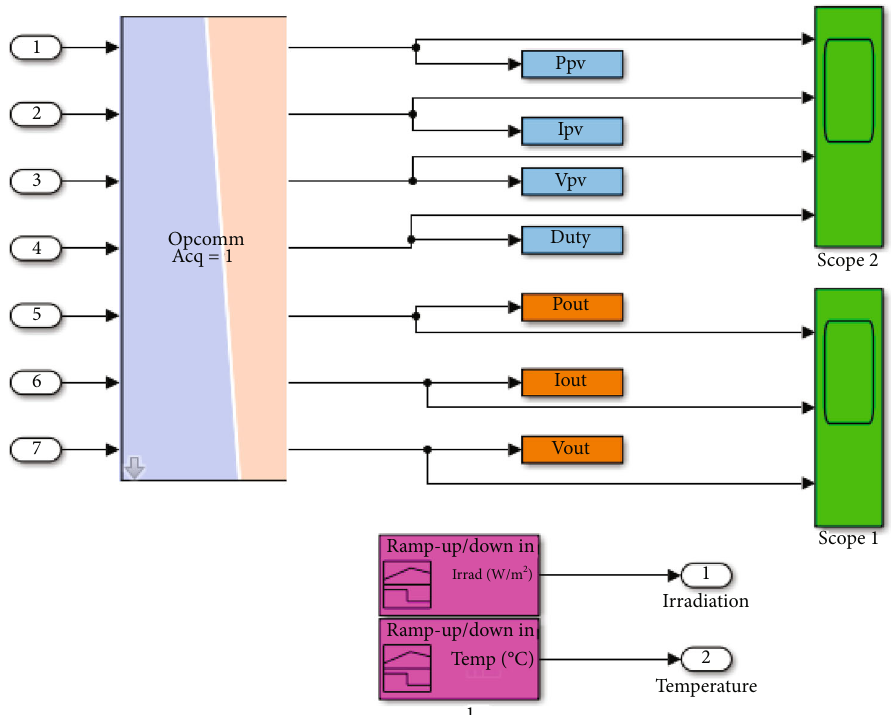
Figure 24: Contents of the SC subsystem diagram before the compilation of RT-LAB.